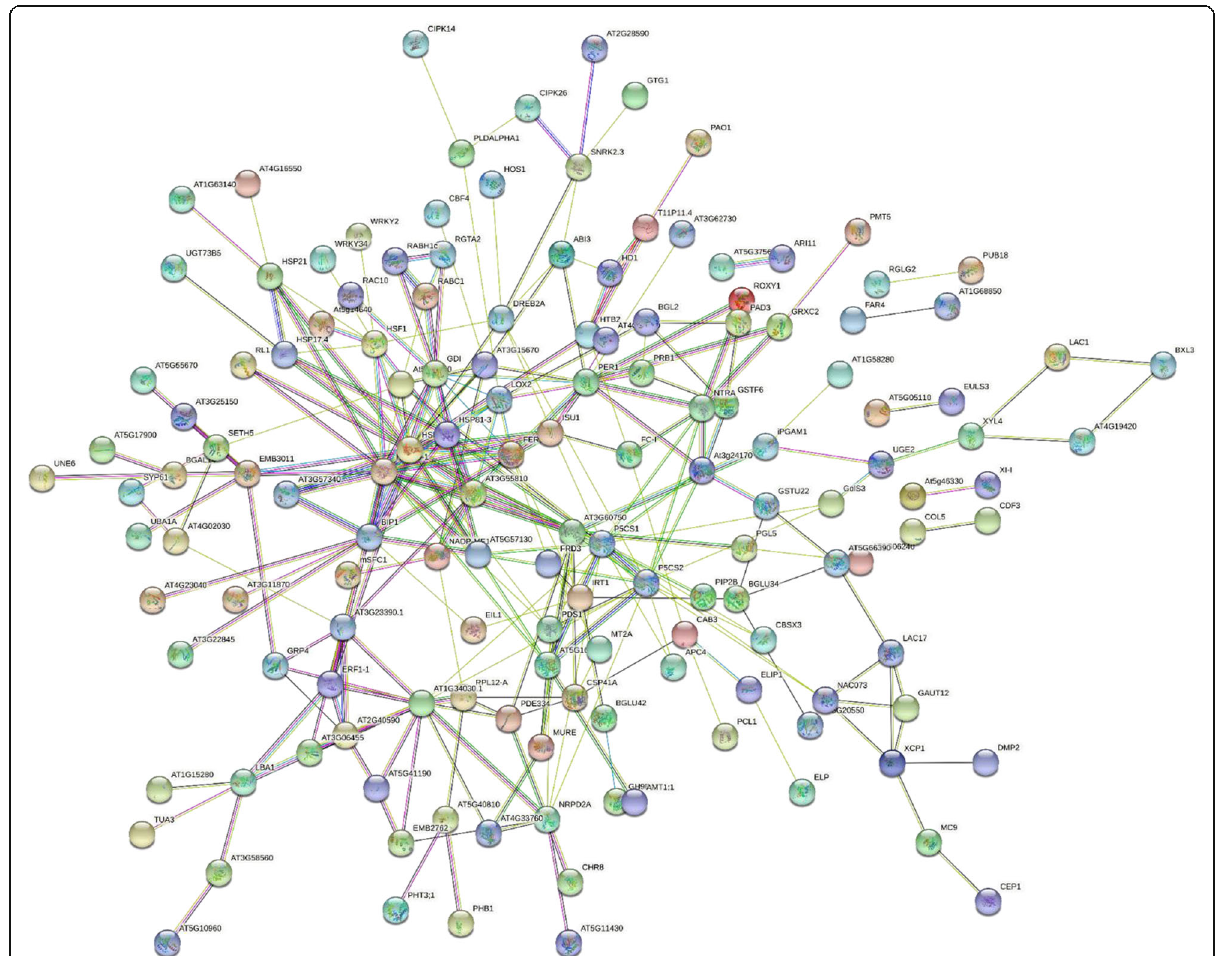
Fig. 1 Network of the genes with differential expression of ≥ 5 and − 5 ≥ at drought stress conditions plus their known neighbors in vegetative and reproductive organs of barley based on the microarray data using web based String